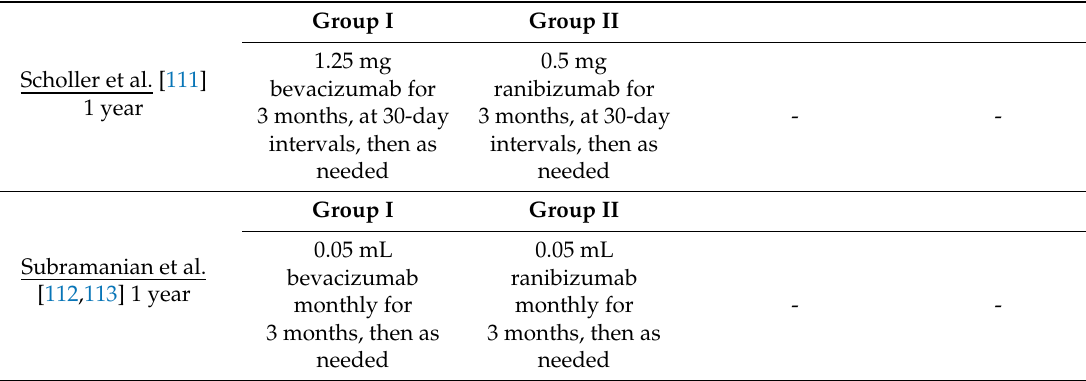
Abbreviations: ANCHOR: Anti-VEGF Antibody for the Treatment of Predominantly Classic Choroidal NeovascularizationinAge-relatedMacularDegeneration; MARINA:MinimallyClassic / OccultTrialoftheAnti-VEGF Antibody Ranibizumab in the Treatment of Neovascular Age-Related Macular Degeneration; PIER: A Phase IIIb, Multicenter, Randomized, Double-Masked, Sham Injection-Controlled Study of the E ffi cacy and Safety of Ranibizumab in Subjects With Subfoveal Choroidal Neovascularization With or Without Classic CNV Secondary to Age-related Macular Degeneration; ABC: Th Avastin ® (Bevacizumab) in Choroidal Neovascularization Trial; CATT: Comparison of Age-related Macular Degeneration Treatment Trials; IVAN: A Randomized Controlled Trial of Alternative Treatments to Inhibit VEGF in Age-related Choroidal Neovascularisation; BRAMD: Comparison of Bevacizumab (Avastin ® ) and Ranibizumab (Lucentis ® ) in Exudative Age-related Macular Degeneration; GEFAL: